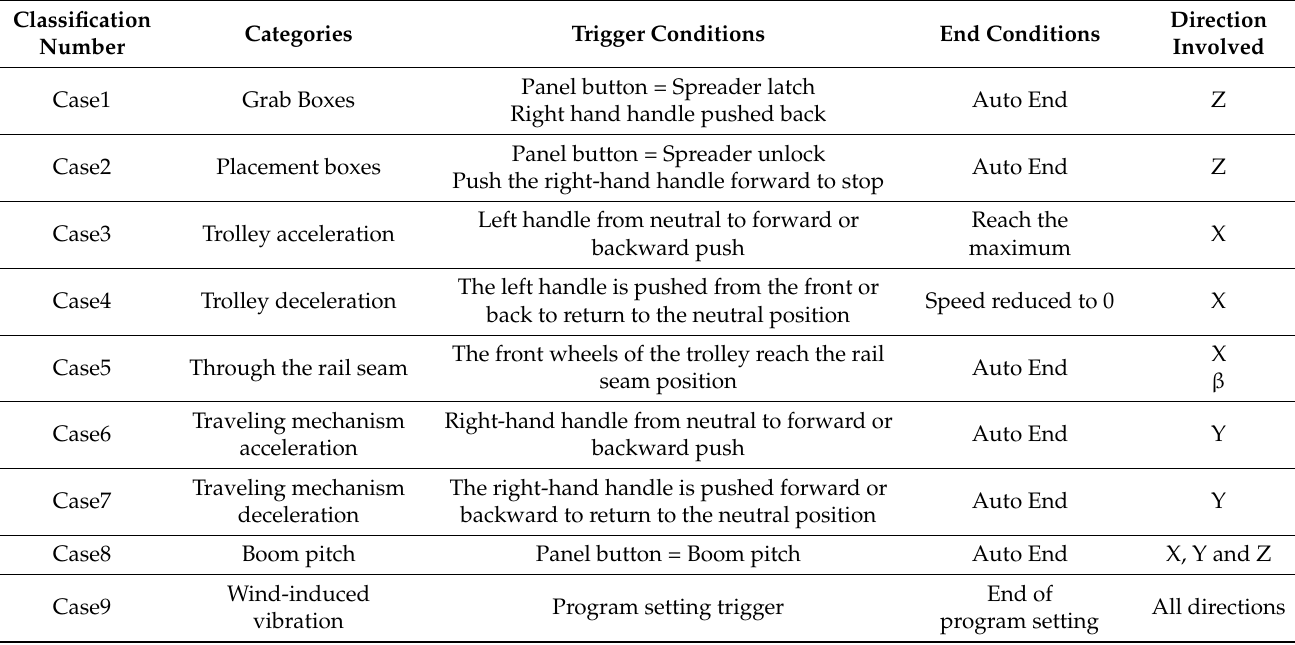
Table 1. Improved scale table based on cloud